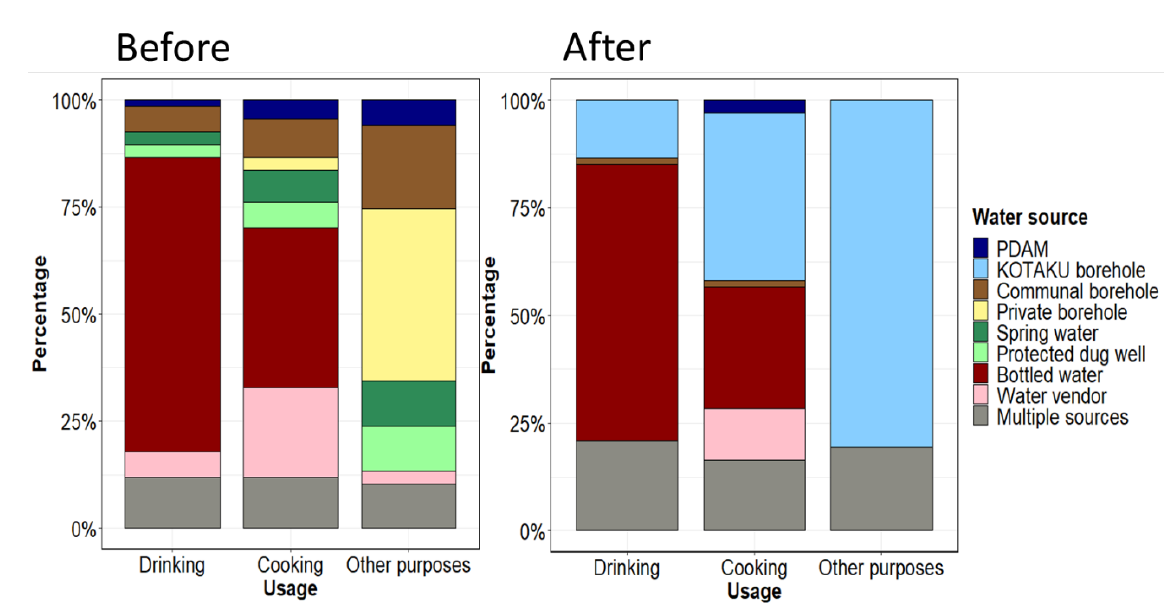
Figure 3. Change of water sources before and after water provision by the KOTAKU program, ( n = 67).